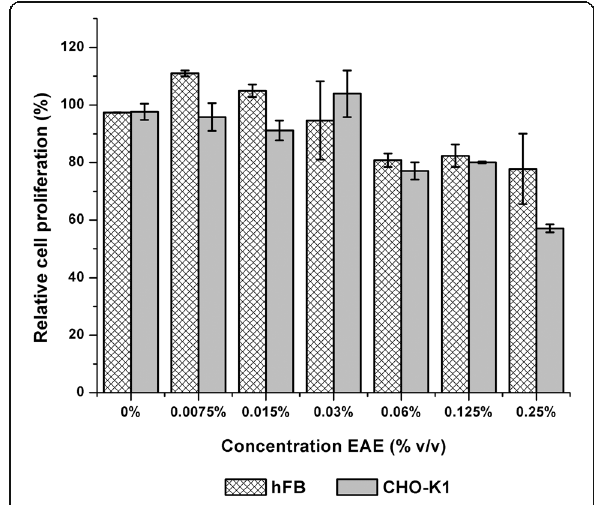
Fig. 3 Effect of ethanolic extract (EAE) on cell lines CHO-K1 and hFB by the MTT test. Error bars represent standard deviation